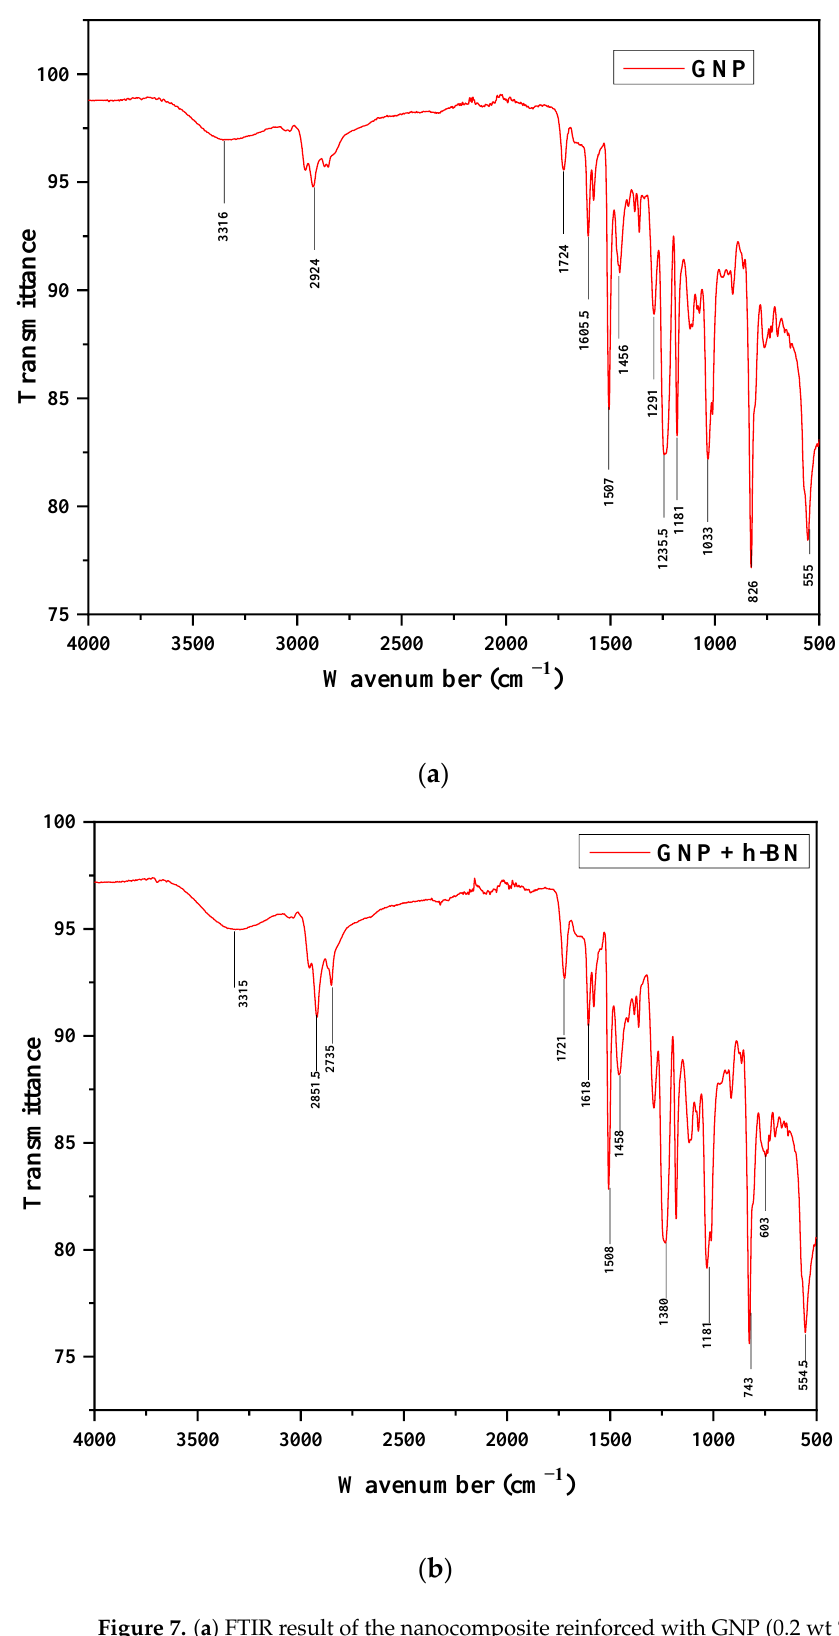
Figure 7. ( a ) FTIR result of the nanocomposite reinforced with GNP (0.2 wt %). ( b ) FTIR result of the composite reinforced with GNP and h-BN (0.6 wt %).